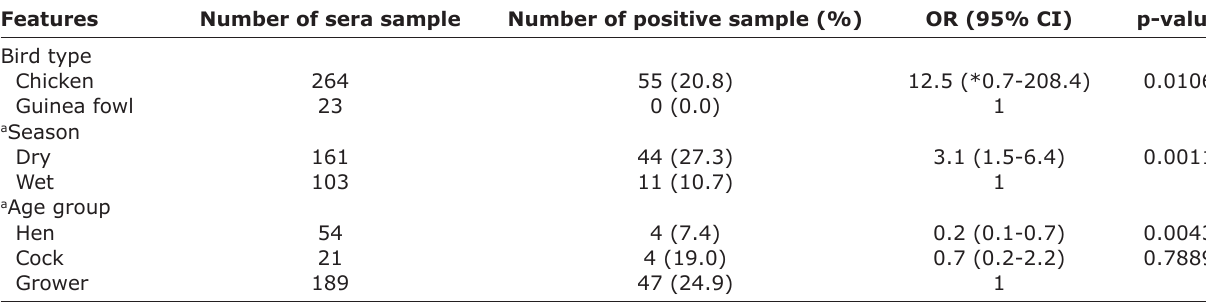
Table-3: Distribution of NDV antibody titers in local chicken and guinea fowl.